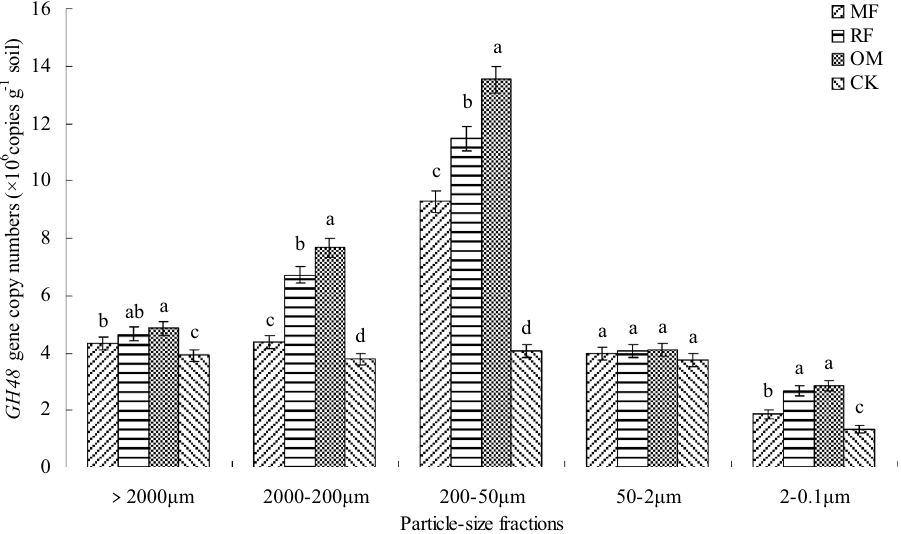
Figure 3. GH48 gene copy numbers in different particle-size fractions with long-term fertilizer treatments. MF chemical fertilizer alone; RF rice straw and chemical fertilizer; OM 30% organic manure and 70% chemical fertilizer; CK without fertilizer input as a control. Different lowercase letters were indicated significant differences ( p < 0.05) among different fertilizer treatments. Error bars represent standard error of the mean (n = 3).